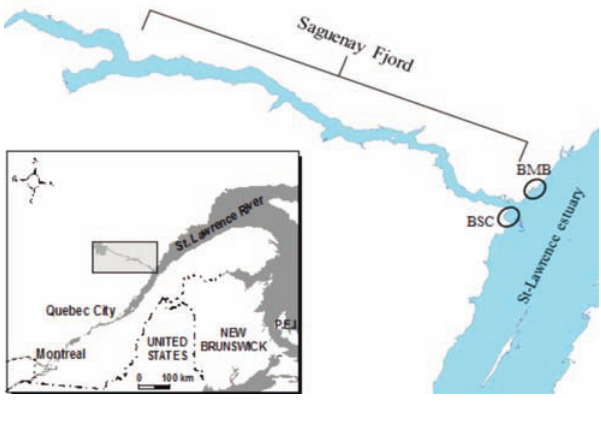
Figure 2. Comparative wet weights of Nereis sp. worms collected at Baie Ste-Catherine (BSC) and Baie du Moulin à Baude (BMB) during the October 2008 survey.